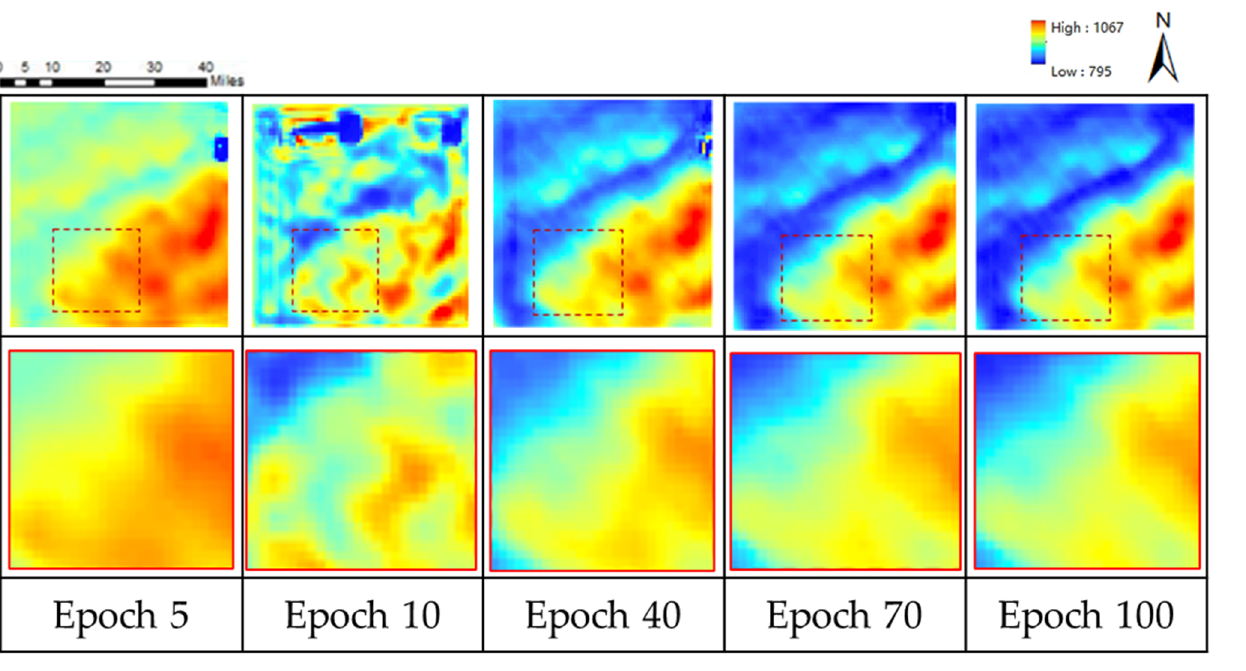
Figure 10. The performance of the proposed GISR during the training process using DEM data (The contents of the solid wireframe are the enlarged details of the dotted wireframe).